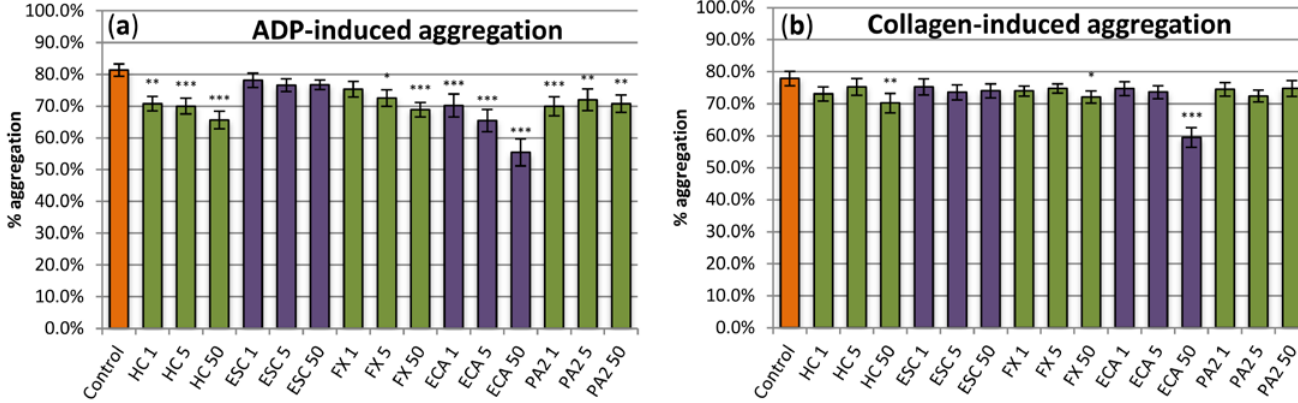
Figure 5. Evaluation of the anti-platelet effects of the examined analytes. The hemostatic response of blood platelets (aggregation in the platelet-rich plasma; PRP) was induced by ( a ) ADP and ( b ) collagen. Results presented as means ± SE ( n = 11). Statistical differences: * p < 0.05, ** p < 0.01, *** p < 0.001 for control platelets versus platelets incubated with analytes. In PRP samples treated with a reference drug, i.e., the aspirin DL-lysine (Lys-ASA; 200 µ g/mL), the ADP- and collagen- induced blood, platelet aggregation was inhibited by 100% ( n = 3). Analytes: HC, horse-chestnut bark extract; ESC, esculin; FX, fraxin, ECA, (-)-epicatechin; PA2, procyanidin A2; the numbers after analyte symbol indicate concentration in µ g/mL.